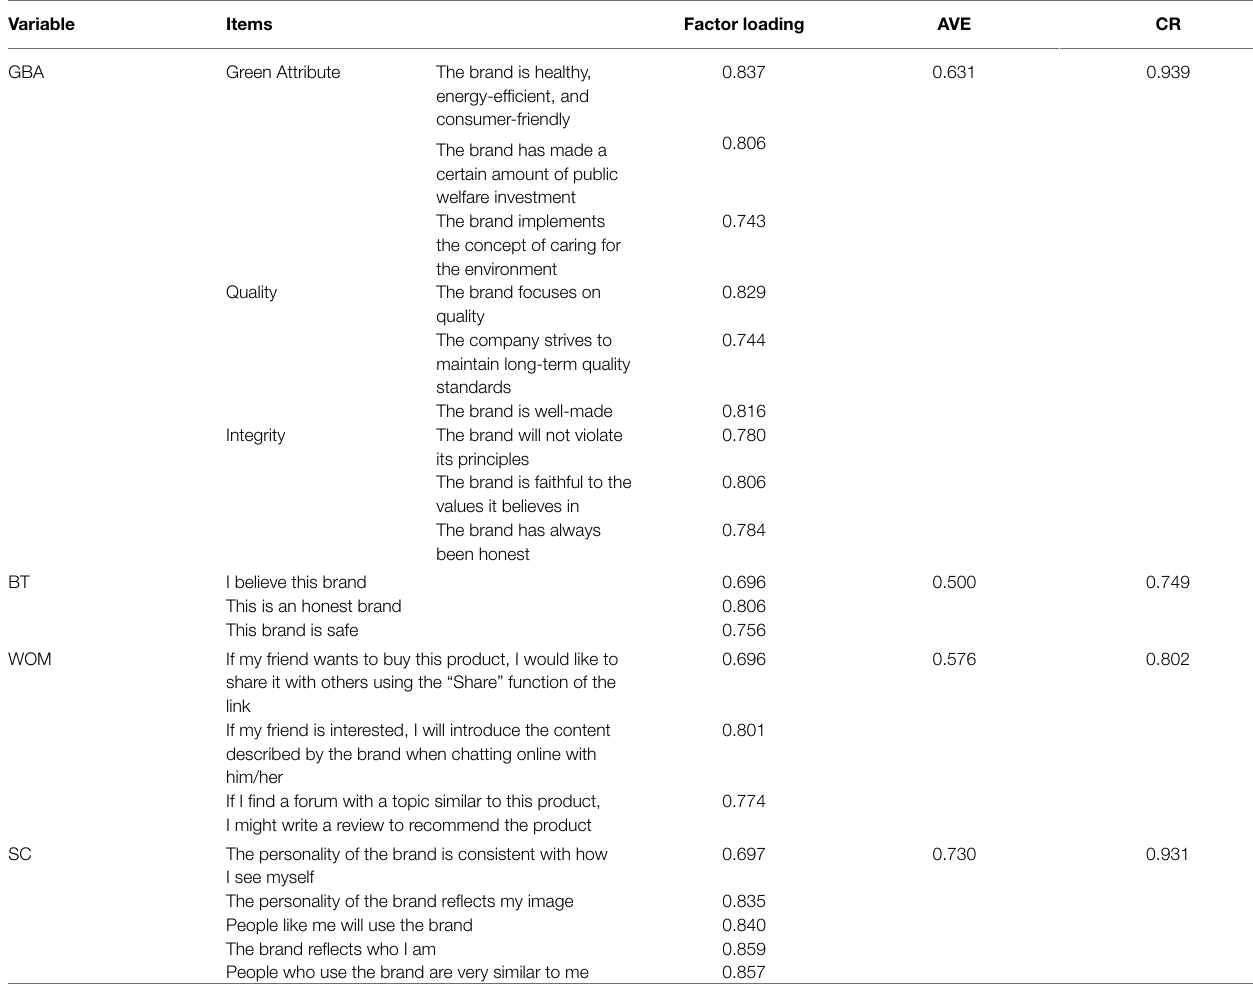
TABLE 1 | Measurement model results.